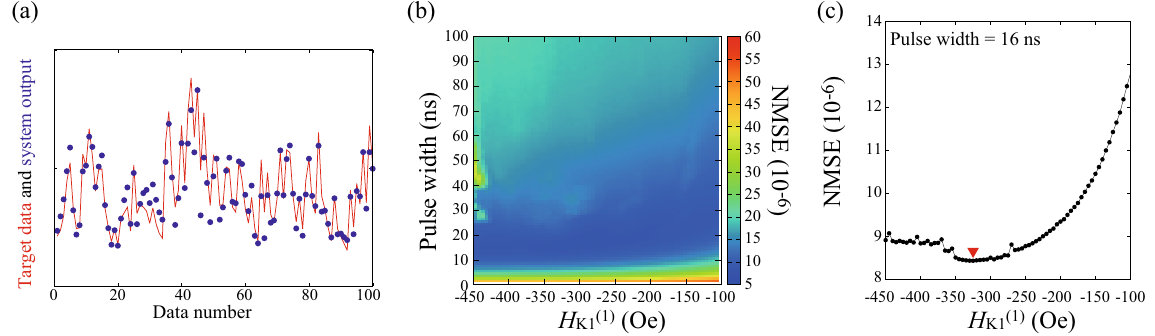
Figure 3. ( a ) Examples of the target data (red line) and the system output (blue dots) of NARMA2 task, where 16 ns and H ( 1 ) 325 Oe. ( b ) Dependence of the NMSE of NARMA2 task on the pulse width and the t p K1 = − = first order magnetic anisotropy field. The lowest value of the NMSE is indicated by the red triangle in ( c